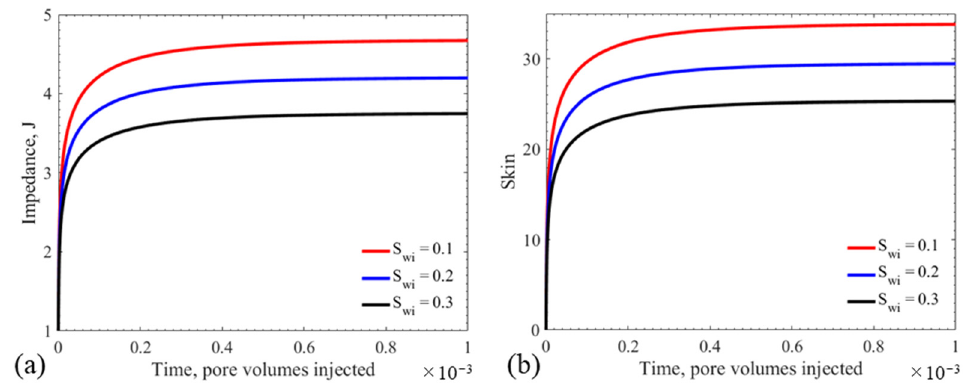
Figure 8. Impedance ( a ) and skin growth ( b ) with time (measured in produced volume as a fraction of the reservoir pore volume) for different connate water saturations.